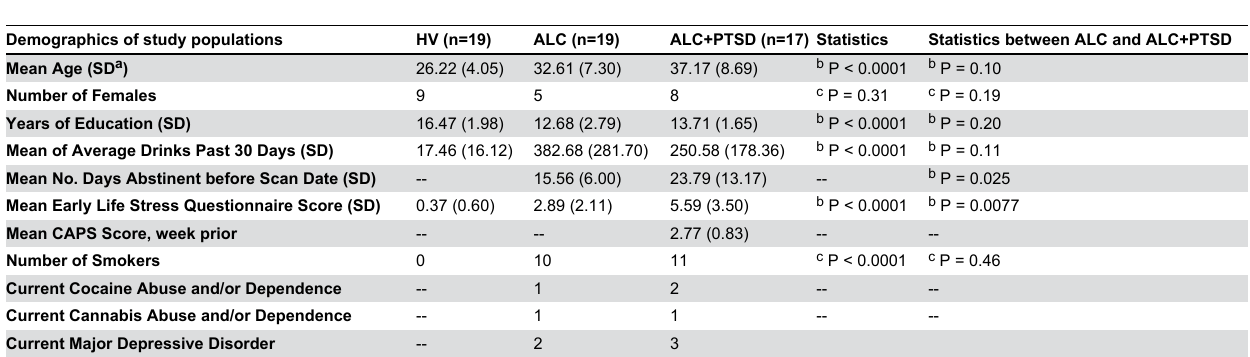
Table 1. Demographic information on healthy volunteers (HV), alcohol dependent subjects without PTSD (ALC), and alcohol dependent subjects with PTSD